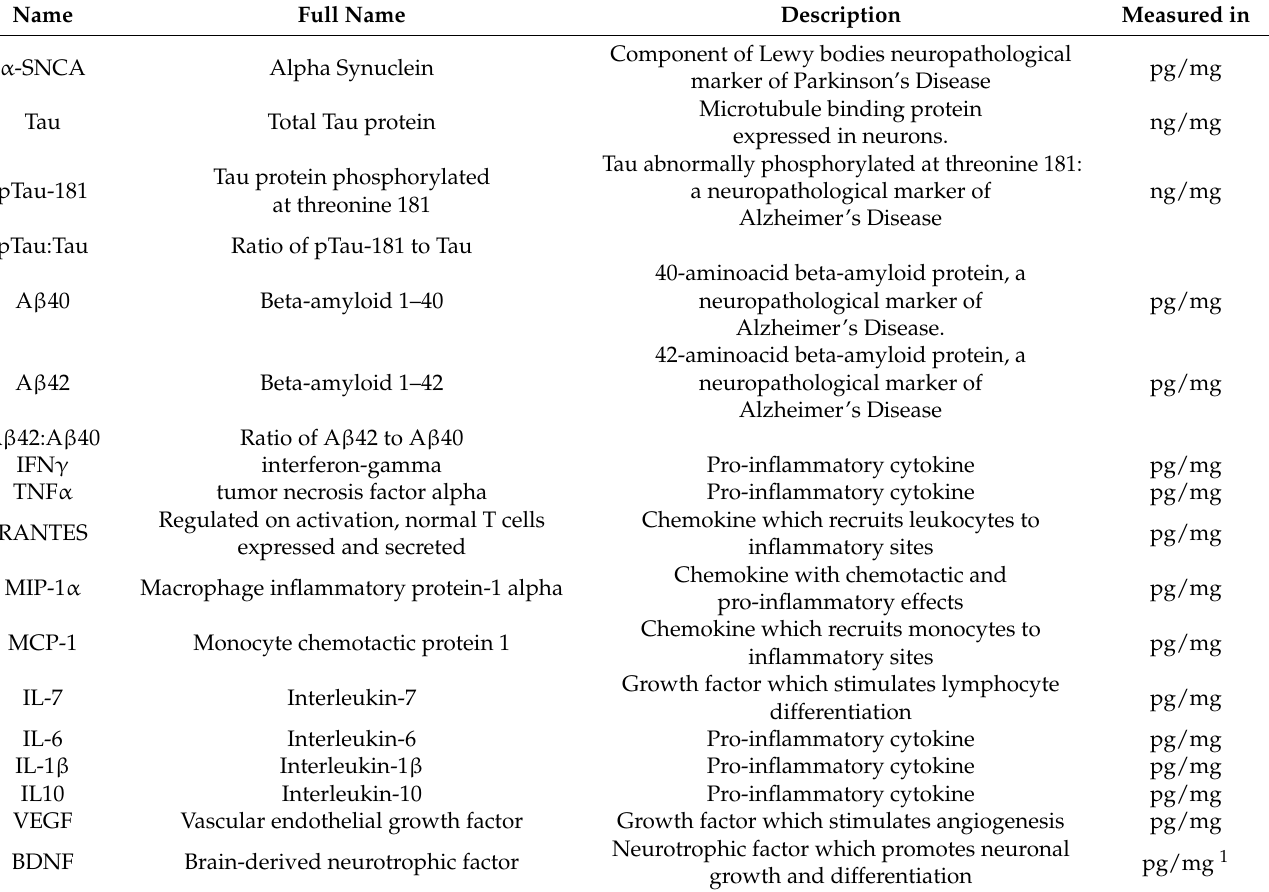
Table 1. Neuropathological, inflammatory, and growth factor proteins quantified by